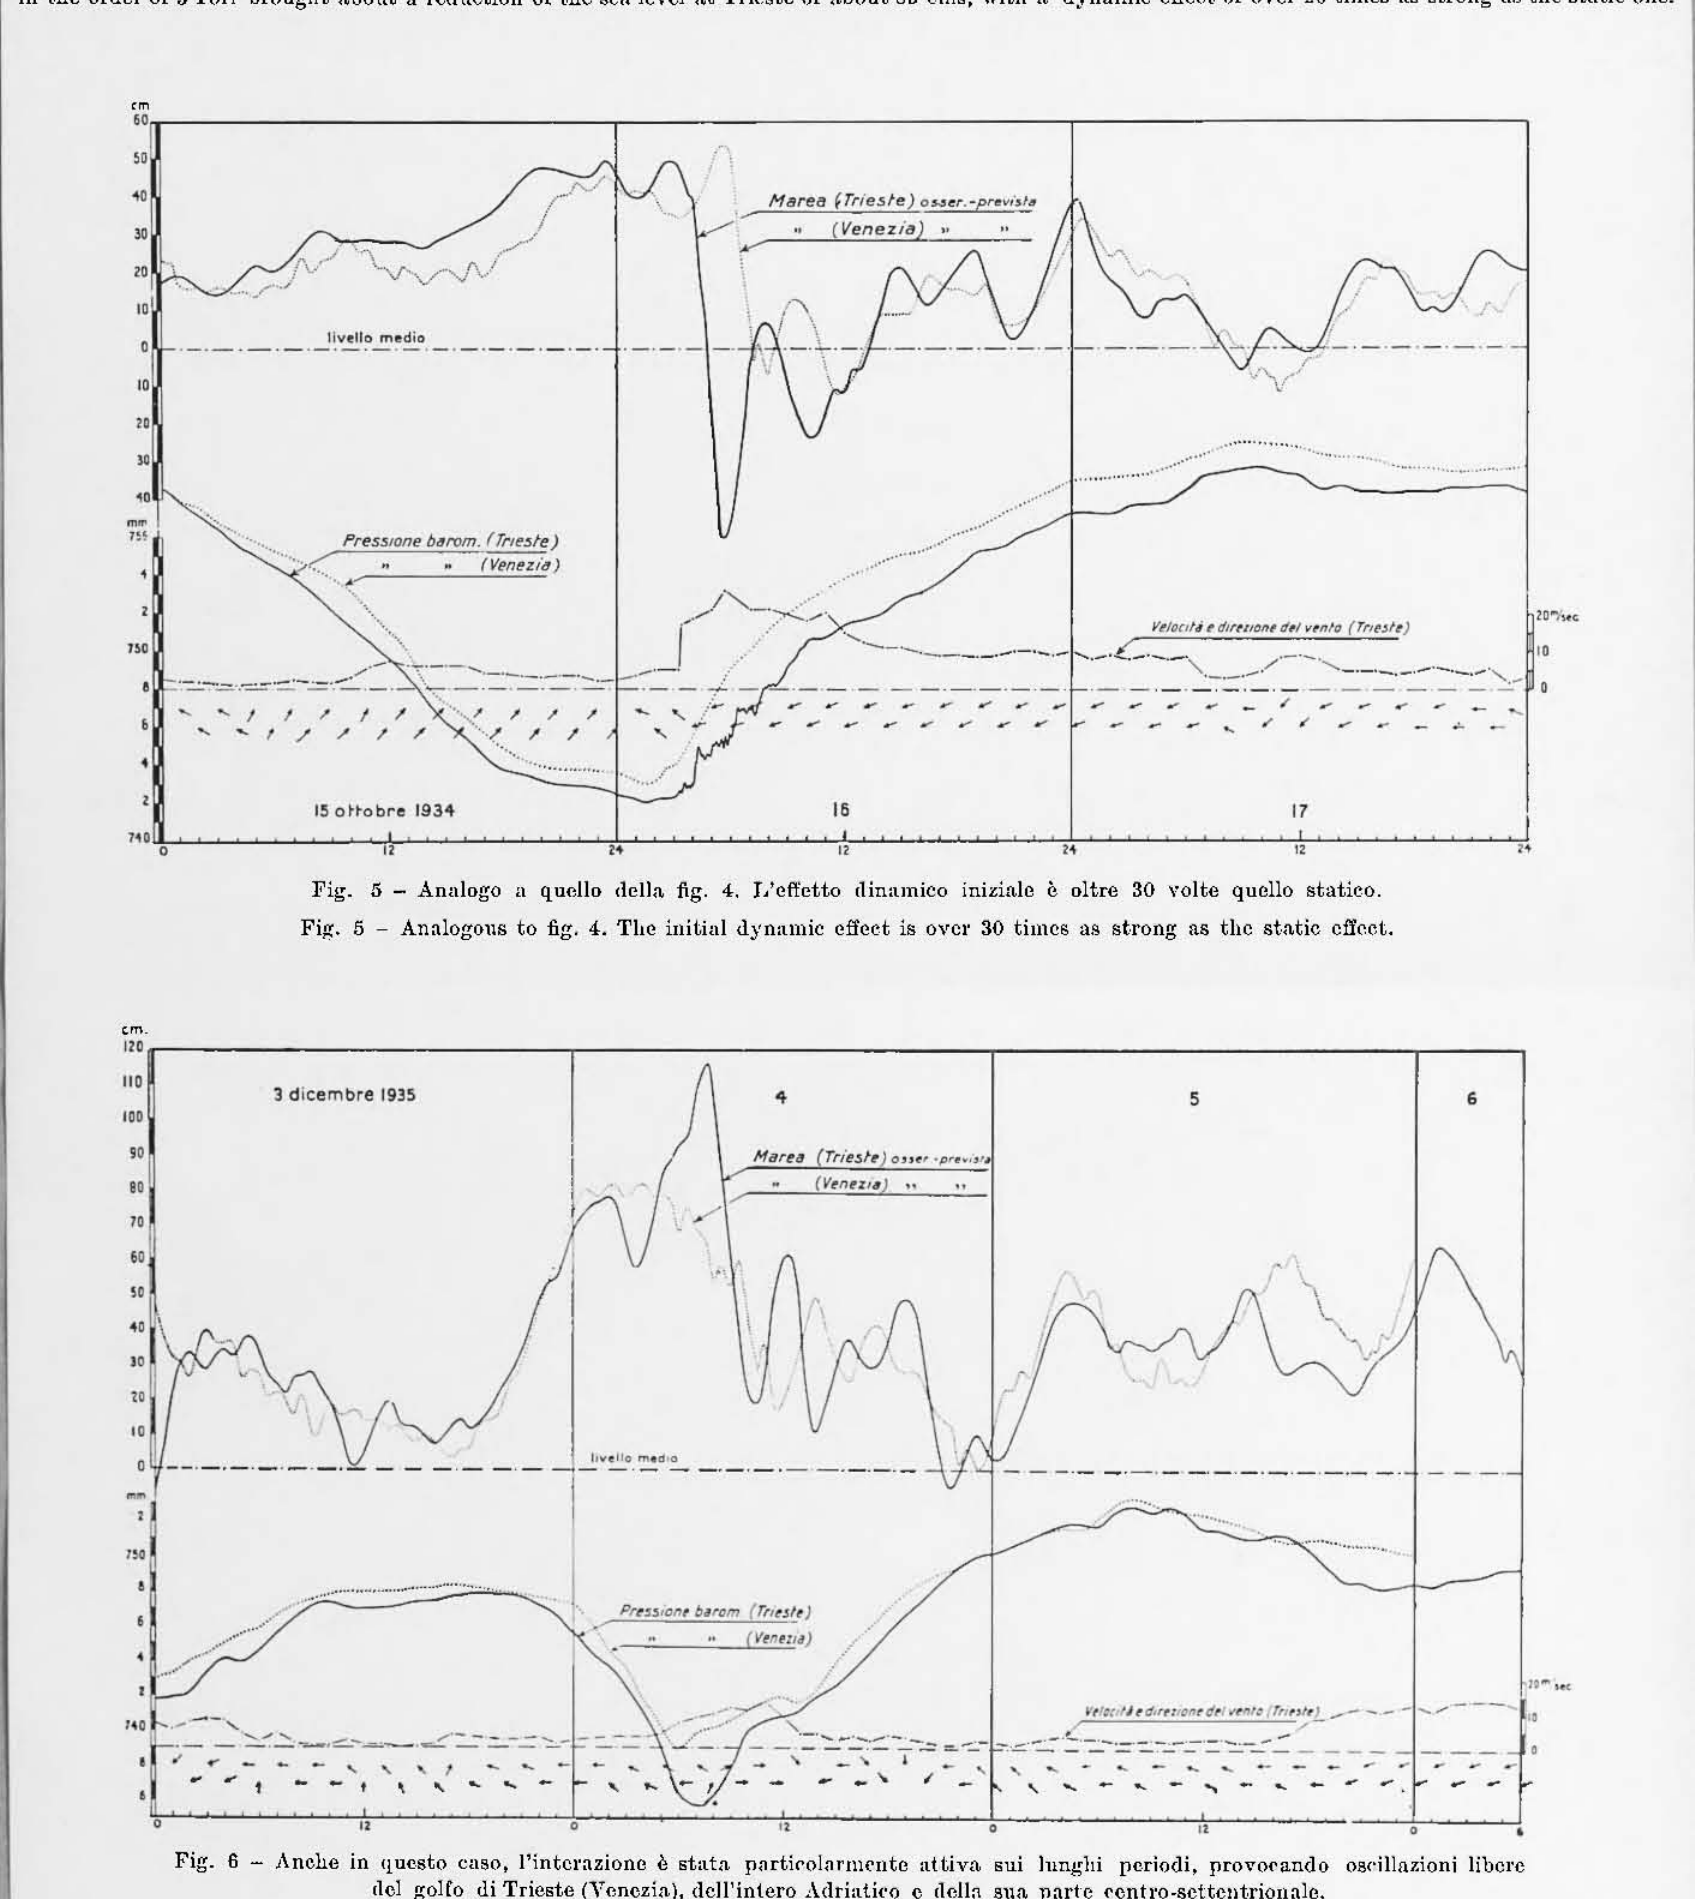
Fig. 6 - Anche in questo caso, j'interazione è stata pnrtiC'olnrnH'nte attiva sui lunghi periodi. provoC'ando oscillazioni libere del golfo ùi Trieste (Venezia), dell'intero Adriatko c deliri Slla parte C'entro·settent,rionale. l"ig:. 6 - In this case, too, the interaetion slJOw('d to ùe particularly adive on thc long !,el'iods; it, bronght ahont fr('e oRcilla. tions or t,he Gulf of Triest,e (Veni{'e), of the C'ntire Adriat,ic t:ìea anù or its ('pntral and northern